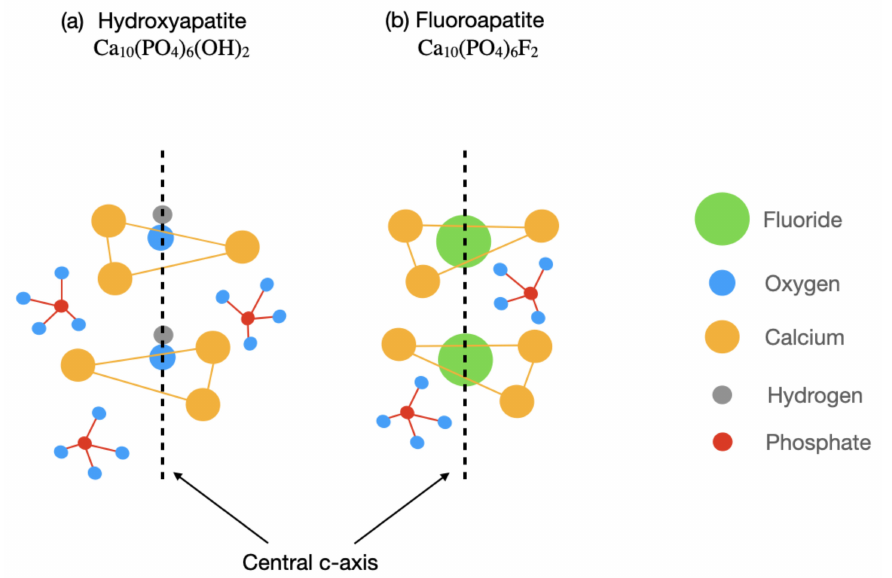
Figure 3. ( a ) Structure of hydroxyapatite: the hydroxyl ion located in the central c-axis is surrounded by calcium and phosphates and by a hexagonal of calcium. ( b ) Representation of the remineralization process: there is replacement of the hydroxyl ion by a fluoride ion in the center of the molecule. The crystal structure of hydroxyapatite exhibits a planar–hexagonal nature of calcium and phosphate ions surrounding the central hydroxyl c-axis